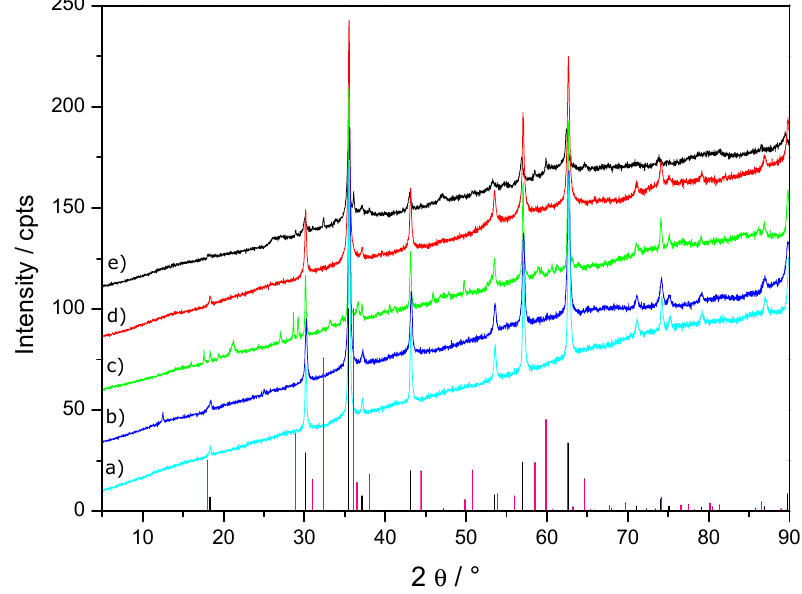
Figure 2. XRD patterns of ( a ) R05F (cyan), ( b ) R05B05F (blue), ( c ) R06F (green), ( d ) R06B02F (red), ( e ) R06B05F (black) samples. Tick marks of the patterns of magnetite (black, ICSD: 01-075-0033) and hausmannite (grey, ICSD: 01-089-4837) are also shown as guidelines.